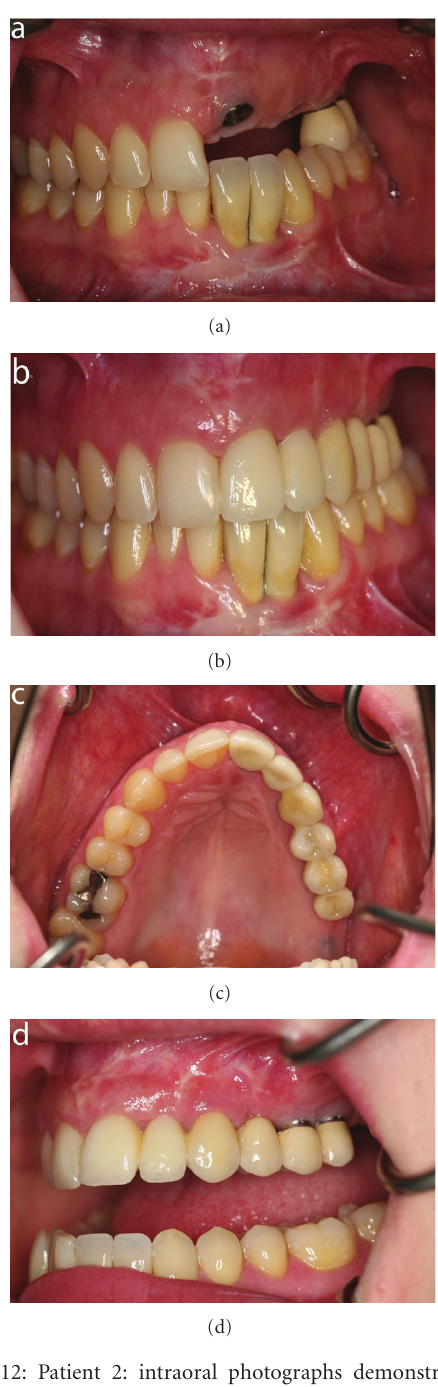
Figure 12: Patient 2: intraoral photographs demonstrating the dentition during and after treatment with dental implants. (a) Frontal view before crowns are inserted on the implants in the left maxillary incisor, canine, and first premolar region. Crowns have been inserted in the left mandibular incisor region. (b) Frontal view after insertion of crowns on the implants. (c) Occlusal view after insertion of crowns on the implants. (d) Lateral view demonstrating the crowns inserted in the implants in the left side of the